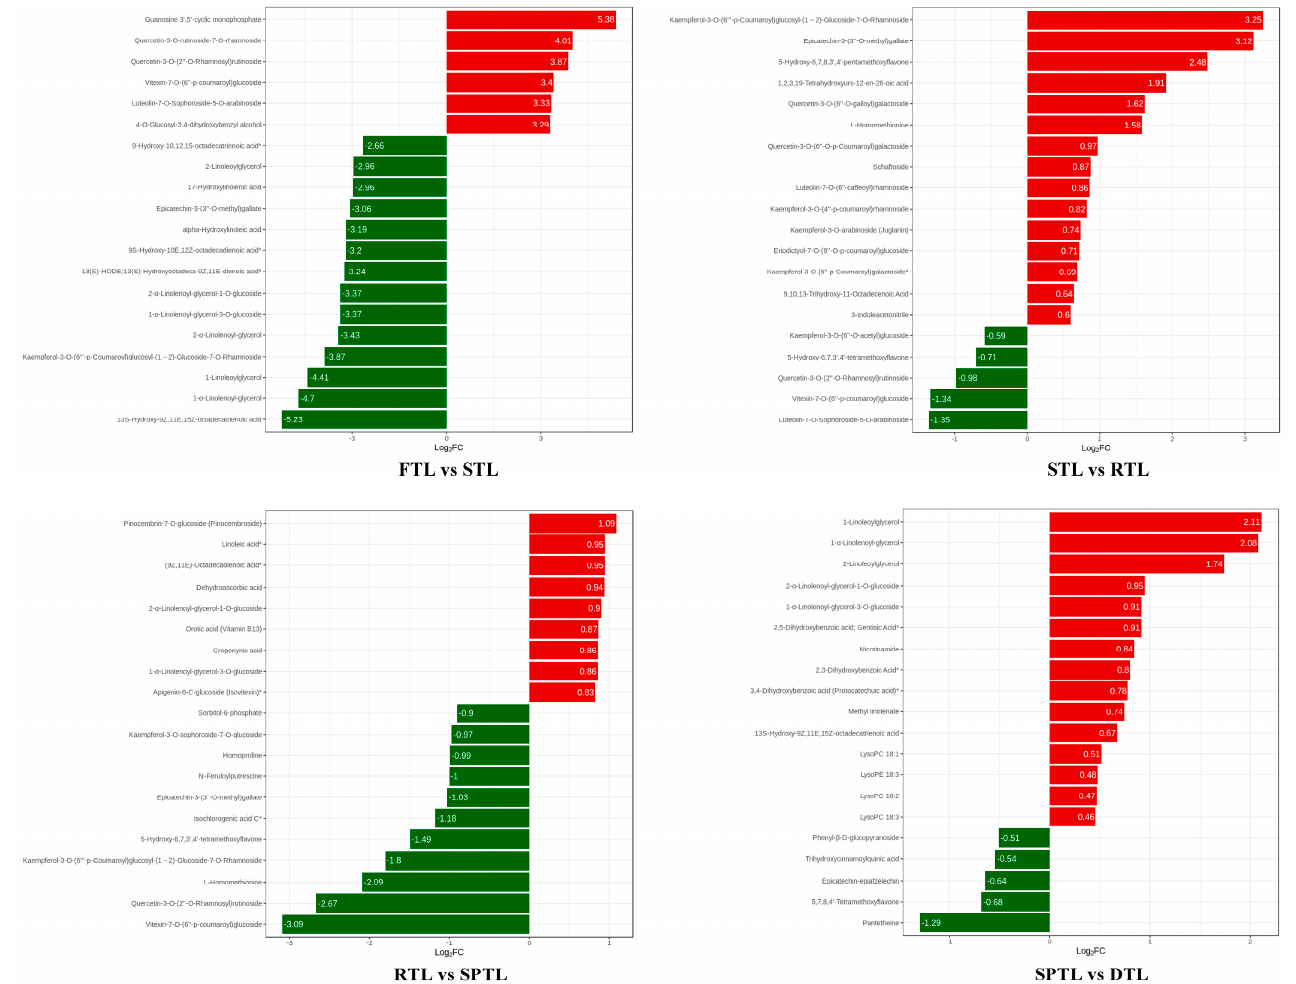
Figure 4. Bar chart of top fold changes in the non-volatile compounds. FC: fold change. “*” indicates the presence of isomers of the substance.